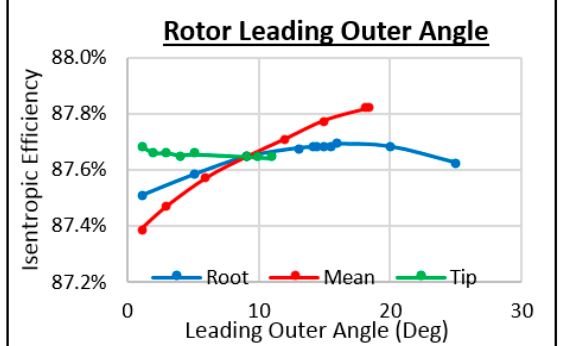
Figure 32. Study of the rotor leading outer angle.